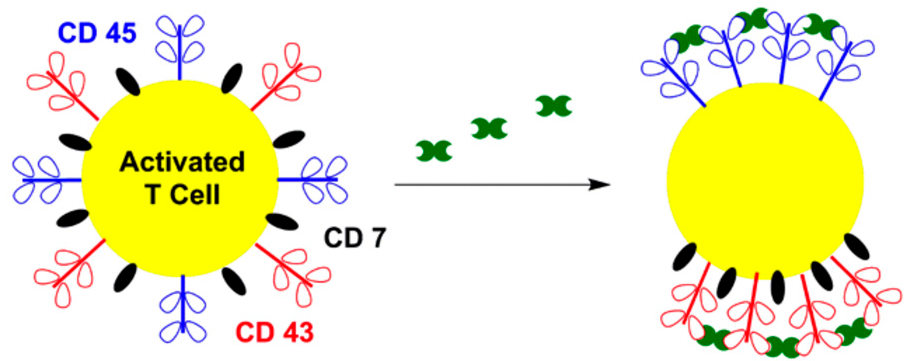
Figure 7. Galectin-1 mediated T cell apoptosis. Galectin-1 induces segregation and clustering of CD45 in distinct microdomains from CD43/CD7 complexes. Green motif, galectin-1.